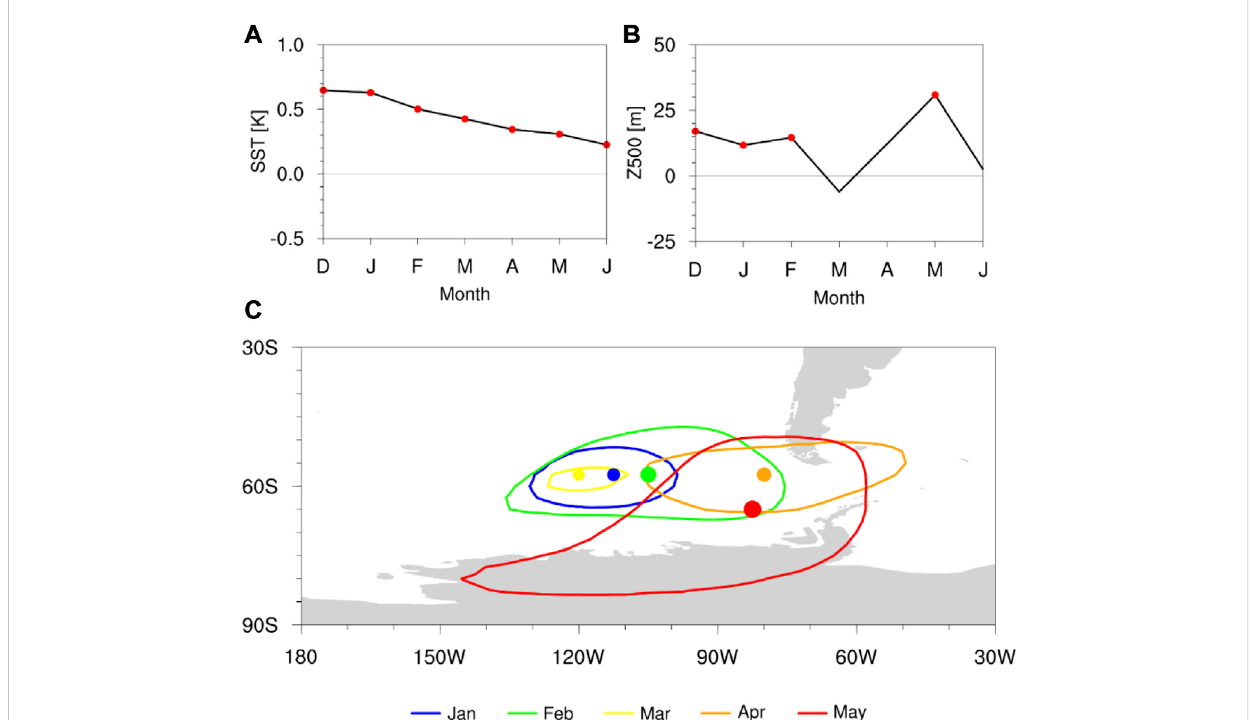
FIGURE 2 Regression coef fi cients of the (A) SST anomaly (K) over the eastern Paci fi c region (160 ° W – 70 ° W, 15 ° S – 15 ° N) and (B) 500-hPa geopotential height anomaly (m) over the Amundsen Sea region (100 ° W – 60 ° W, 80 ° S – 60 ° S). The red dot represents the statistically signi fi cant value at 95% con fi dence level. (C) HorizontaldistributionoftheENSO-drivenanticycloniccirculationanomalyneartheAmundsenSeaineachmonthfromJanuarytoMay.Thecontour is 20 m of the 500-hPa geopotential height anomaly inthe regressionmap. The inside dot and its size denote the location of thecenter and relative intensity of the circulation anomaly, respectively. The colors represent each month (de fi ned in the